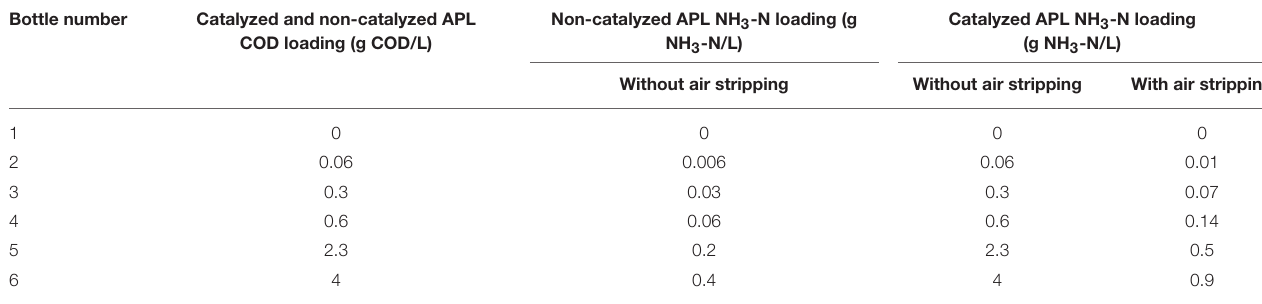
TABLE 1 | ATA COD and NH 3 -N loadings for catalyzed and non-catalyzed APL. Bottle number